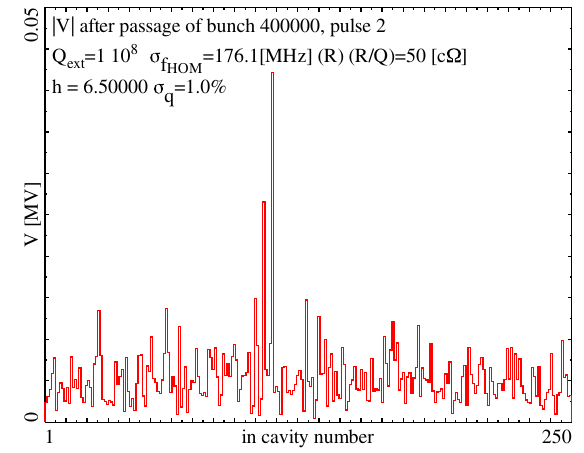
FIG. 37. (Color) Cavity voltages [0–0.05 MV] corresponding to the above case ( Q ext ¼ 10 8 ).